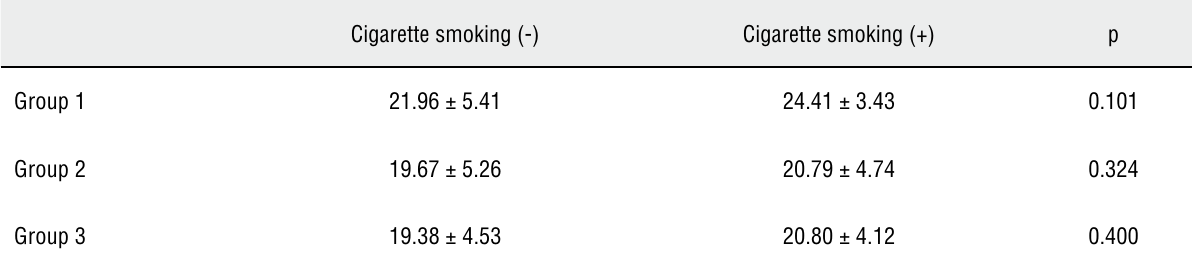
Table 7 - The impact of cigarette smoking and number of occluded vessels on IIEF